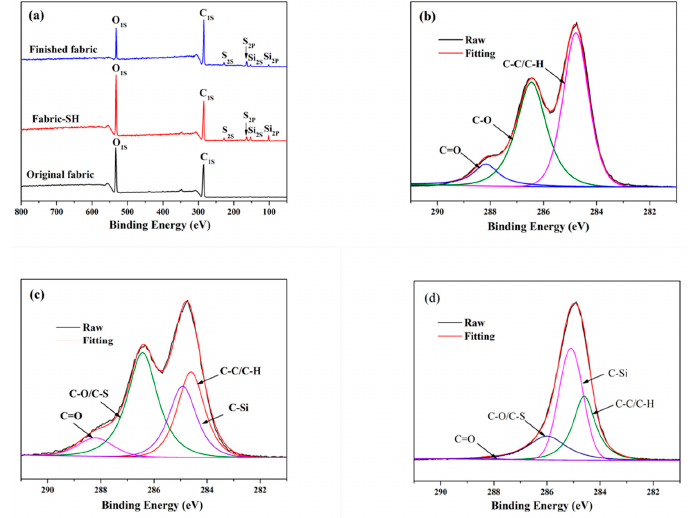
Figure 5. ( a ) XPS spectra of the original fabric, fabric-SH and finished fabric; high-resolution C 1 s spectra of the original fabric ( b ), fabric-SH ( c ) and finished fabric ( d ).